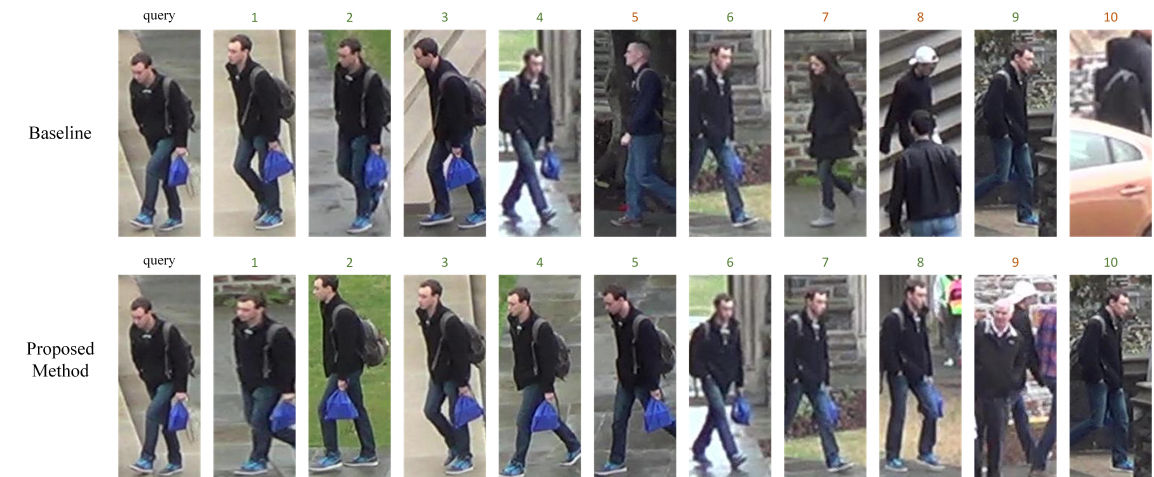
Figure 6. Comparison of retrieval results on the DukeMTMC-ReID